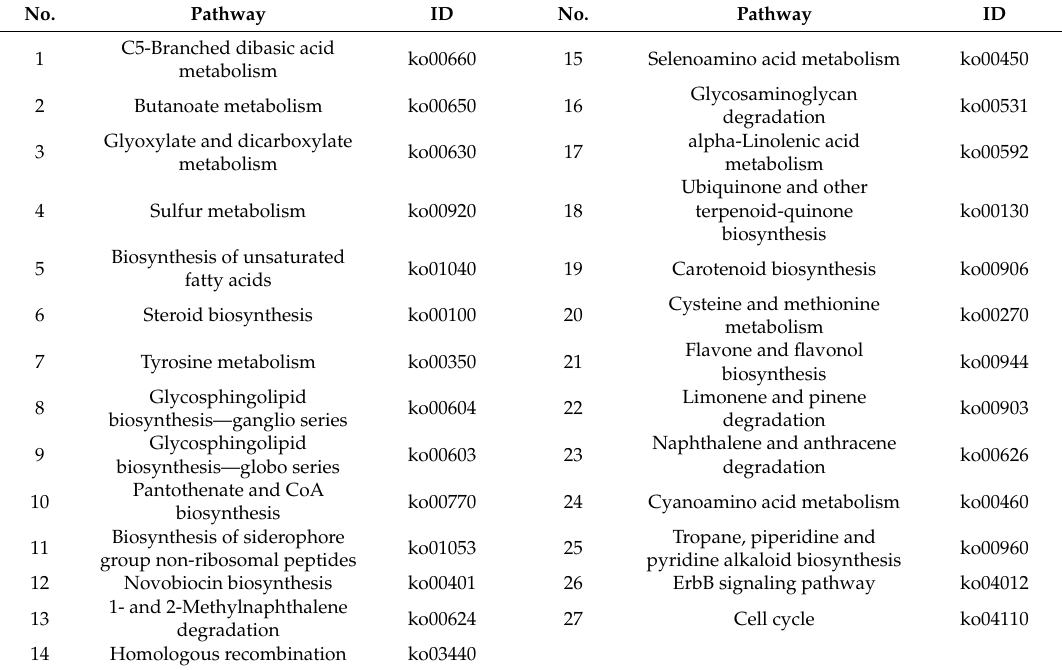
Table 5. Significant enrichment pathways of P. edulis ‘Pachyloen’.